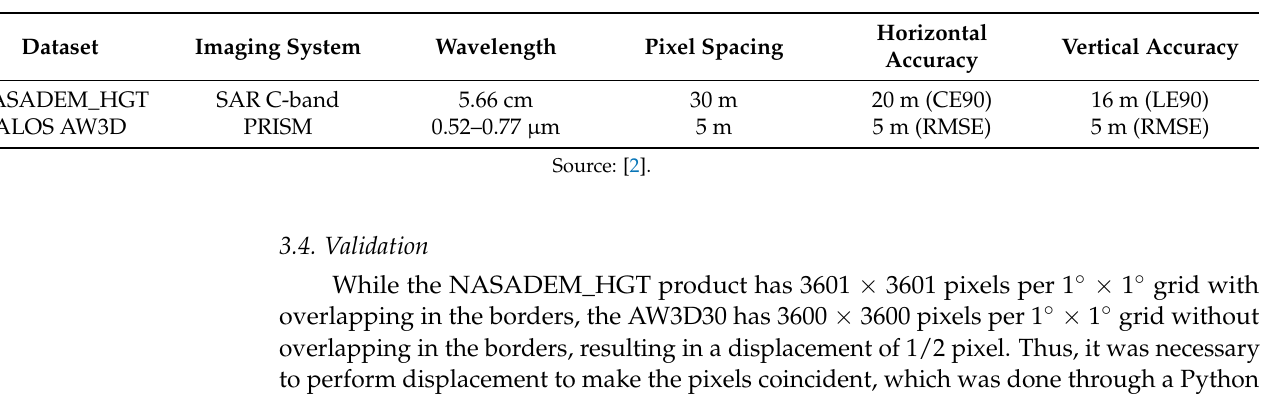
Table 3. Characteristics and global accuracy (90% of the data (CE90), 90% confidence of vertical accuracy (LE90), and root mean square error (RMSE)) of the datasets used in this